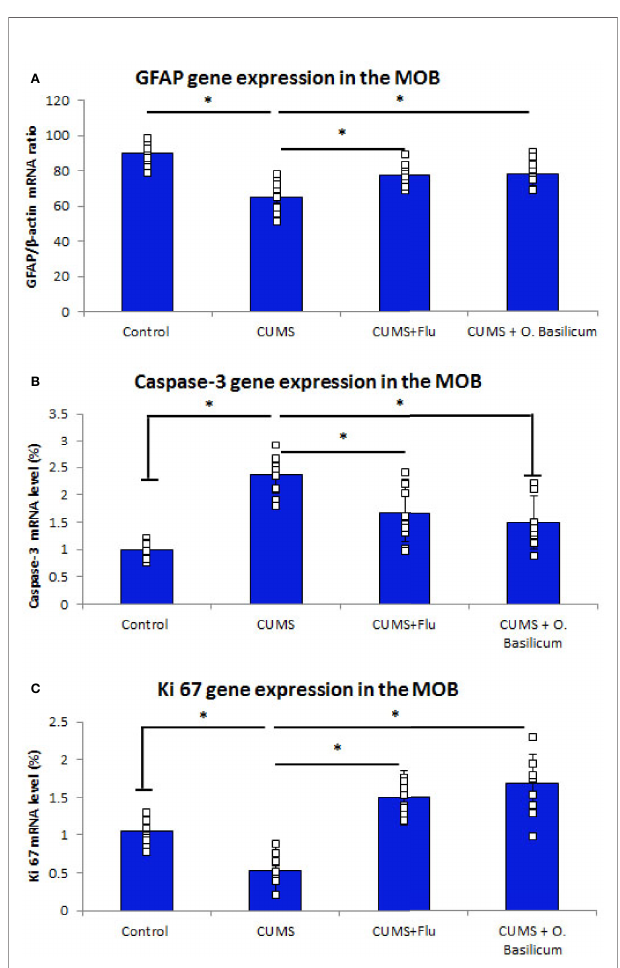
FIGURE 2 | Effect of Ocimum basilicum on GFAP (A) , caspase-3 (B) , Ki 67 (C) mRNA levels detected by real-time PCR (RT-PCR) in the main olfactory bulb (MOB) after treatment of chronic unpredictable mild stress (CUMS) in rats with fl uoxetine (FLU) and O. basilicum . The messenger RNA (mRNA) level was expressed as a ratio or percent to that of corresponding b -actin. Data were presented as mean ± SD (n=10 in each group). * signi fi cance with